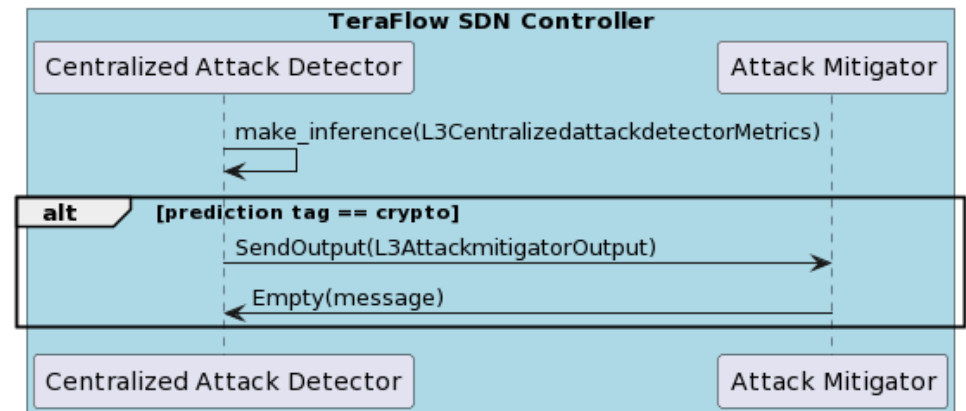
Figure 5. Centralized Attack Detector component